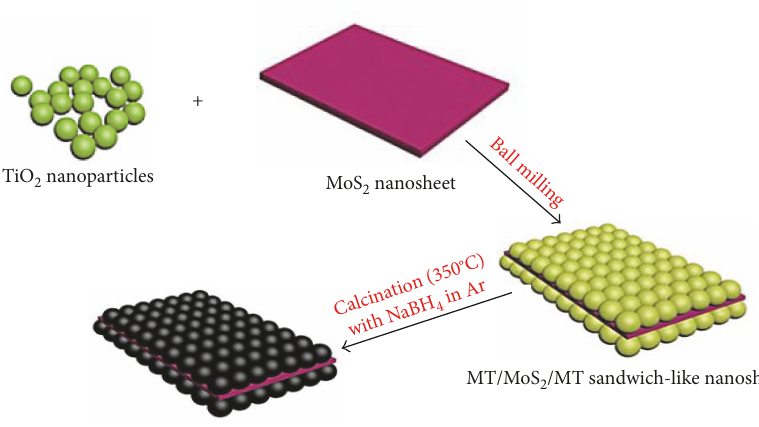
Figure 9: Preparation of MBT/MoS /MBT sandwich-like nanosheets. Reprinted with permission from [85]. Copyright (2016) 2